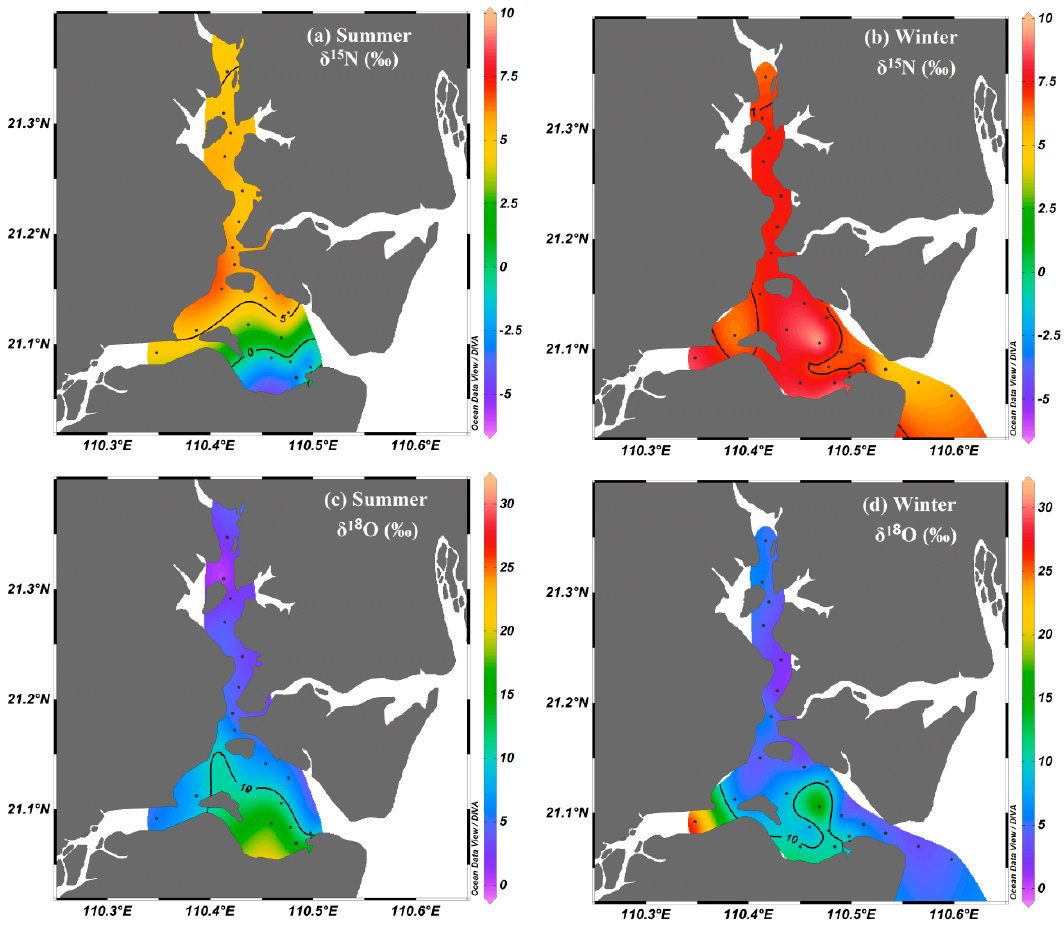
Figure 5. Spatial and seasonal distributions of ( a ) δ 15 N-NO 3 − and ( b ) δ 18 O-NO 3 − in the surface water of Zhanjiang Bay.